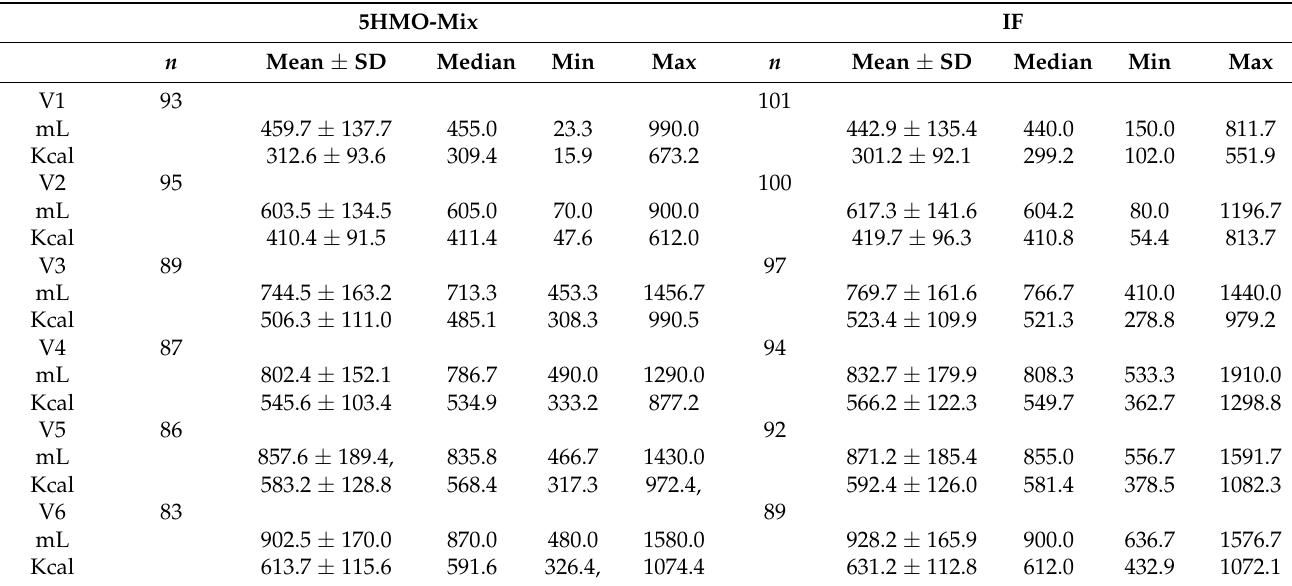
Table 4. Average daily intake of infant formula (mL/day) and average kcal intake after V1 and before V2, V3, V4, V5, and V6